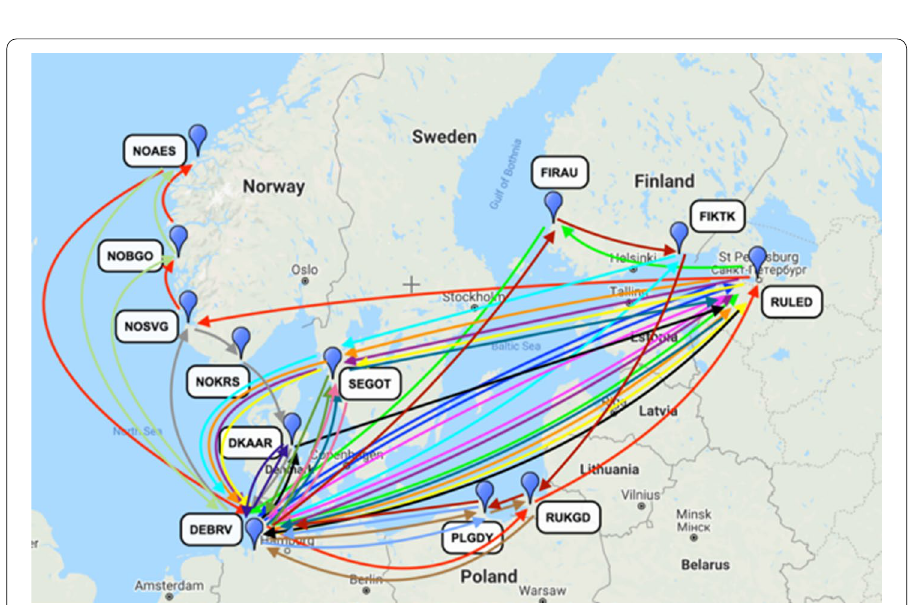
Fig. 3 Routes obtained for the LSNDP with dynamic